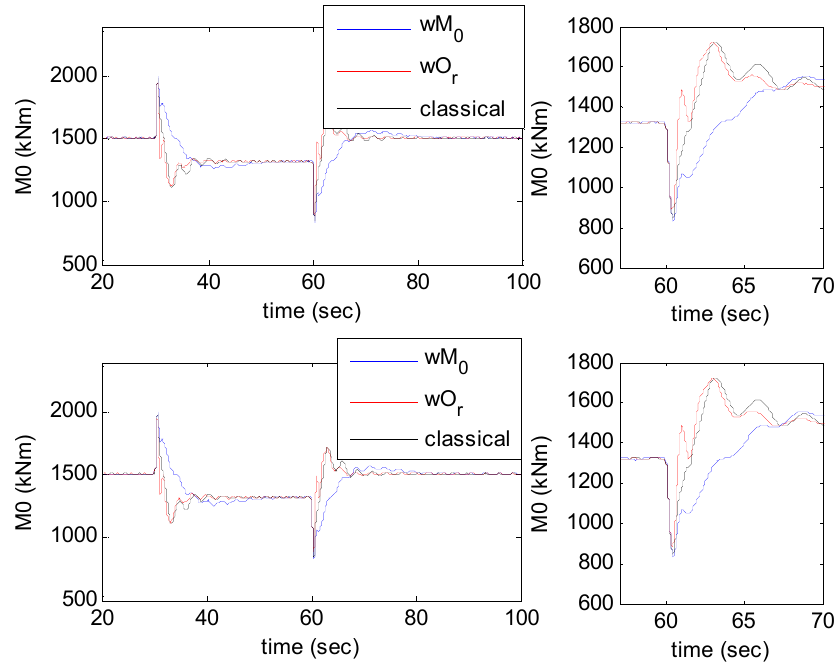
Figure 7. Responses of collective blade bending moments: ( a ) without IPC; ( b ) with IPC.